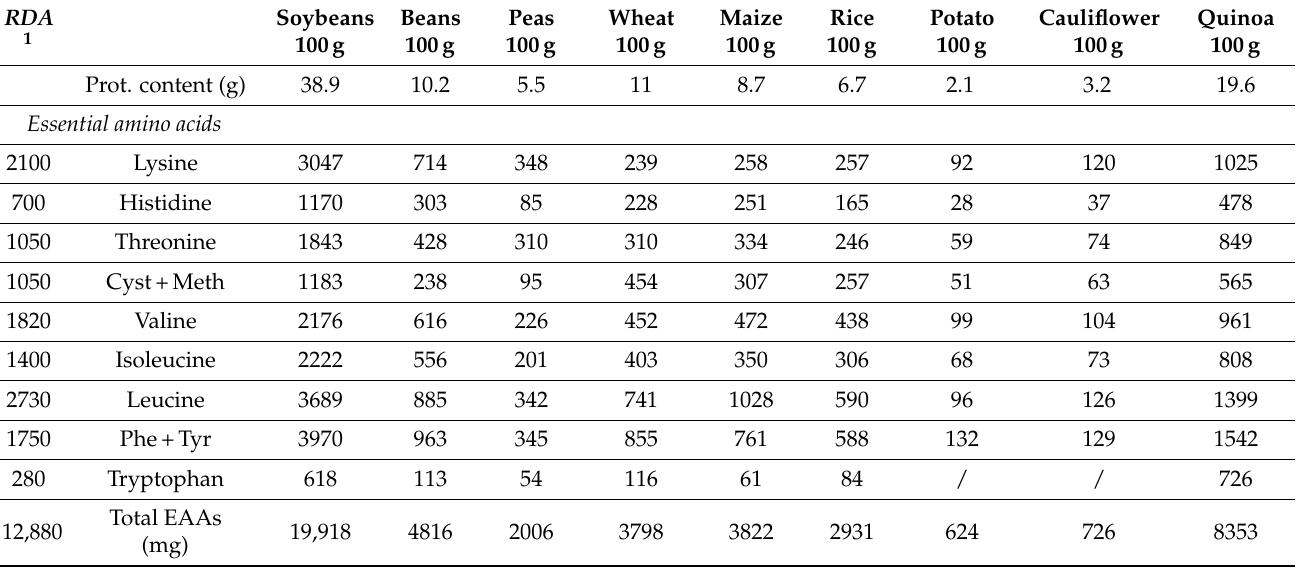
Table 5. Recommended daily doses for a 70 kg male, and AAs in various foods: vegetable source foods. Reprinted with permission from